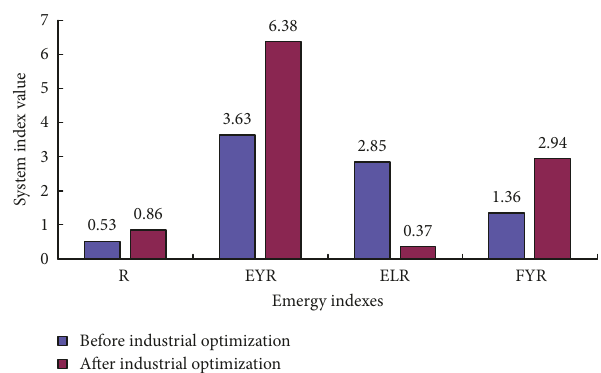
Figure 7: Comparison results of system emergy before and after optimization of ecological agriculture industry industry.